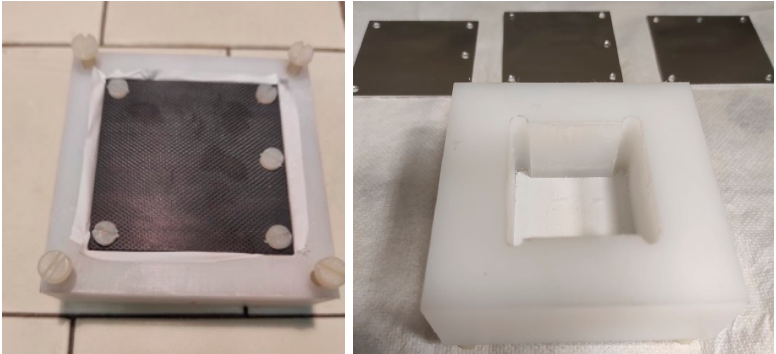
Figure 16. Left: the mini-well assembly with a carbon fiber substrate on the bottom. Right: the setup at the end of the deposition. Figure 16. ( Left ): the mini-well assembly with a carbon fiber substrate on the bottom. ( Right ): the setup at the end of the deposition.